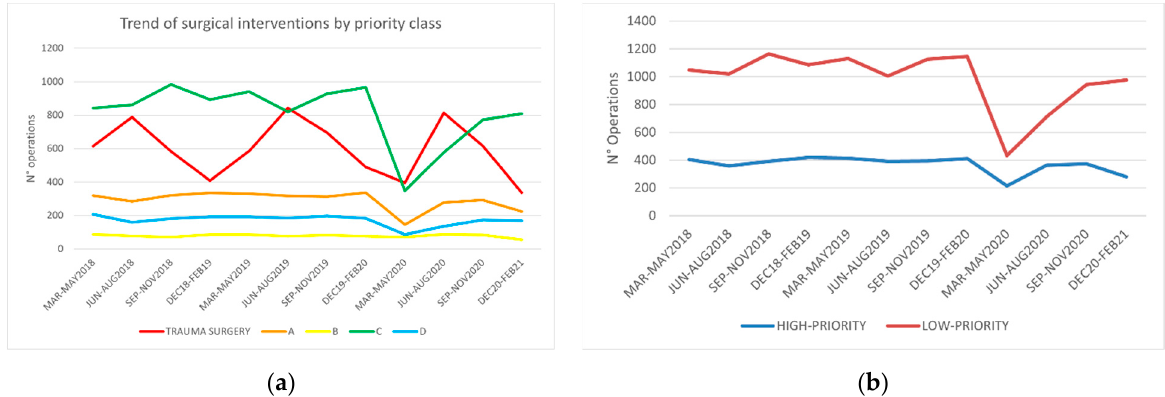
Figure 2. Trend of surgical operations during the period March 2018–February 2021: ( a ) divided by priority class; ( b ) divided high-priority/low-priority. Table 3. Relative change in medical and surgical volumes, during the year of COVID-19, divided by quarter.